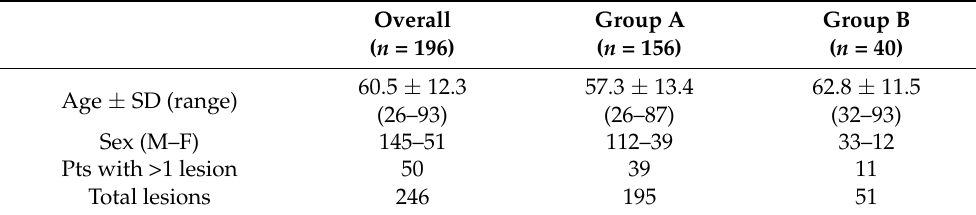
Table 1. Patients’ demographic information